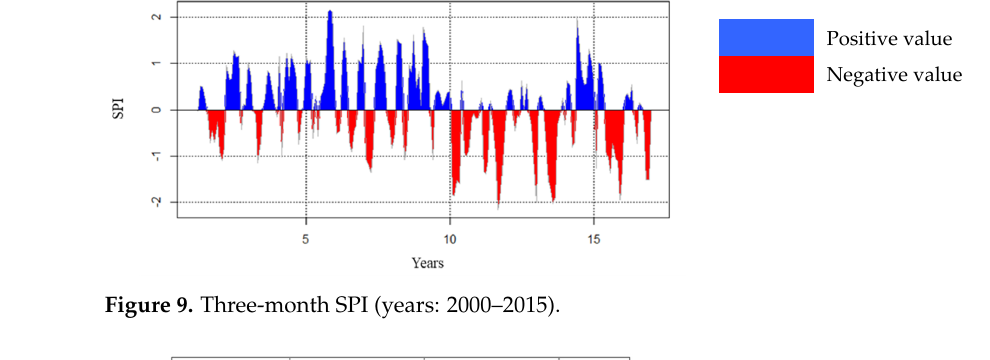
Figure 8. One-month SPI (years: 2000–2015). Figure 8. One ‐ month SPI (years: 2000–2015).